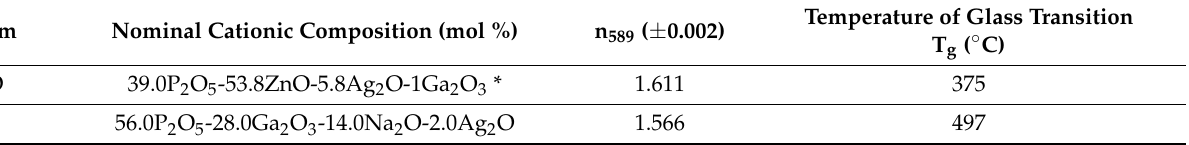
Table 1. The different properties of the two glass